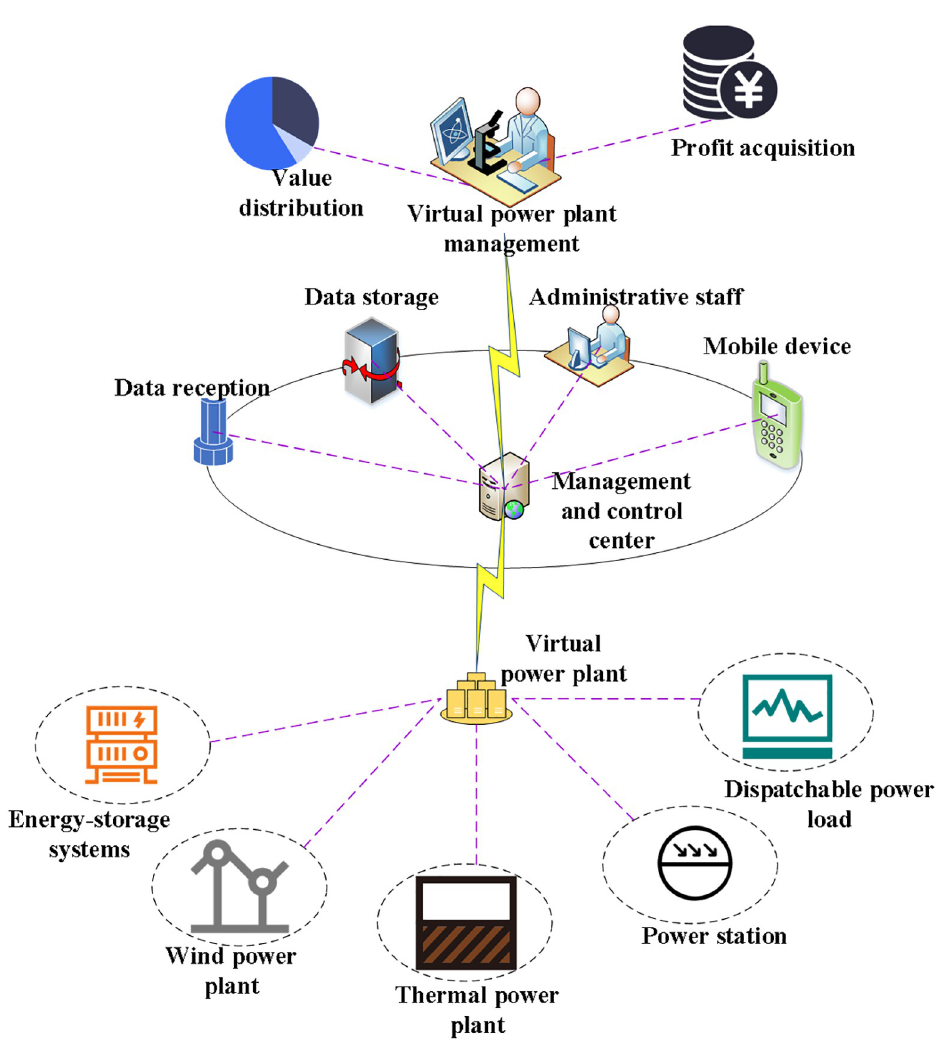
Fig 2. Structure of the electricity market transaction model under Stackelberg